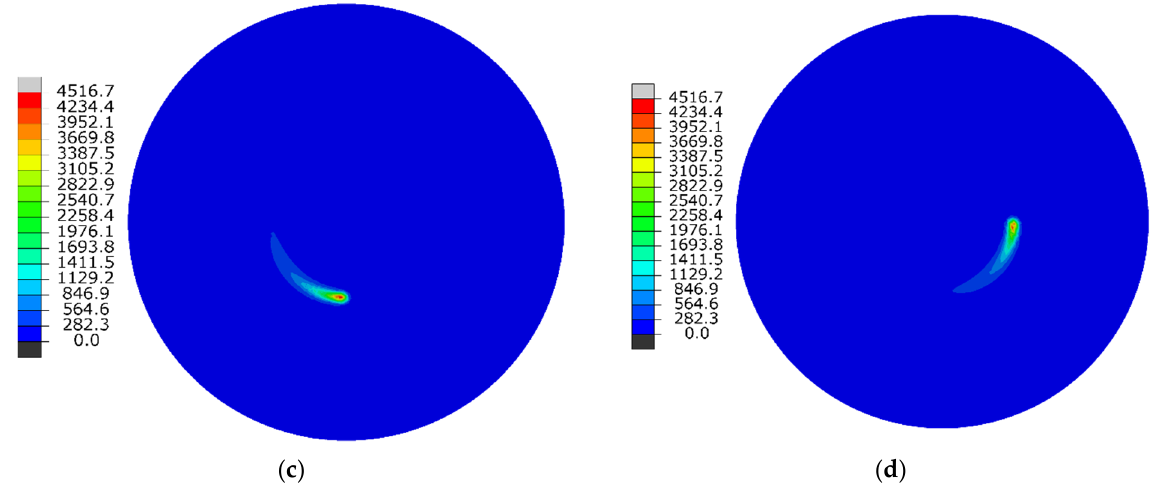
Figure 8. Temperature field variation of sapphire laser cutting material based on ABAQUS at different times. ( a ) t = 0.1 S. ( b ) t = 0.2 S. ( c ) t = 0.3 S. ( d ) t = 0.4 S.